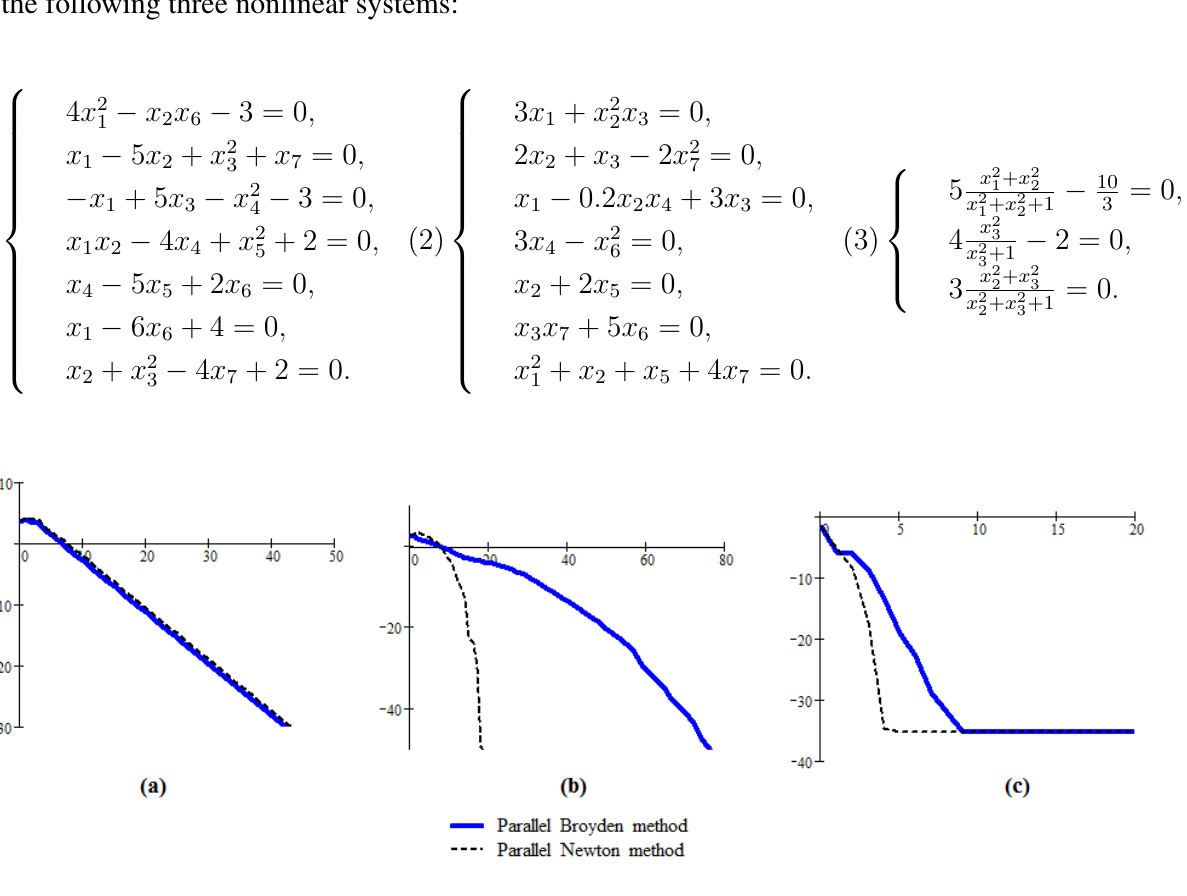
) generated by Algorithm 5 and parallel Newton method; Figure 3. The graphs of ln ( ε n ( a ) the graph corresponding to systems (1); ( b ) the graph corresponding to systems (2) given by Algorithm 5 modified in accordance with Sherman-Morrison lemma; ( c ) example of a ) − 1 (cid:107)(cid:107) E (cid:107) < 1 system verifying the condition (cid:107) D ( x n n